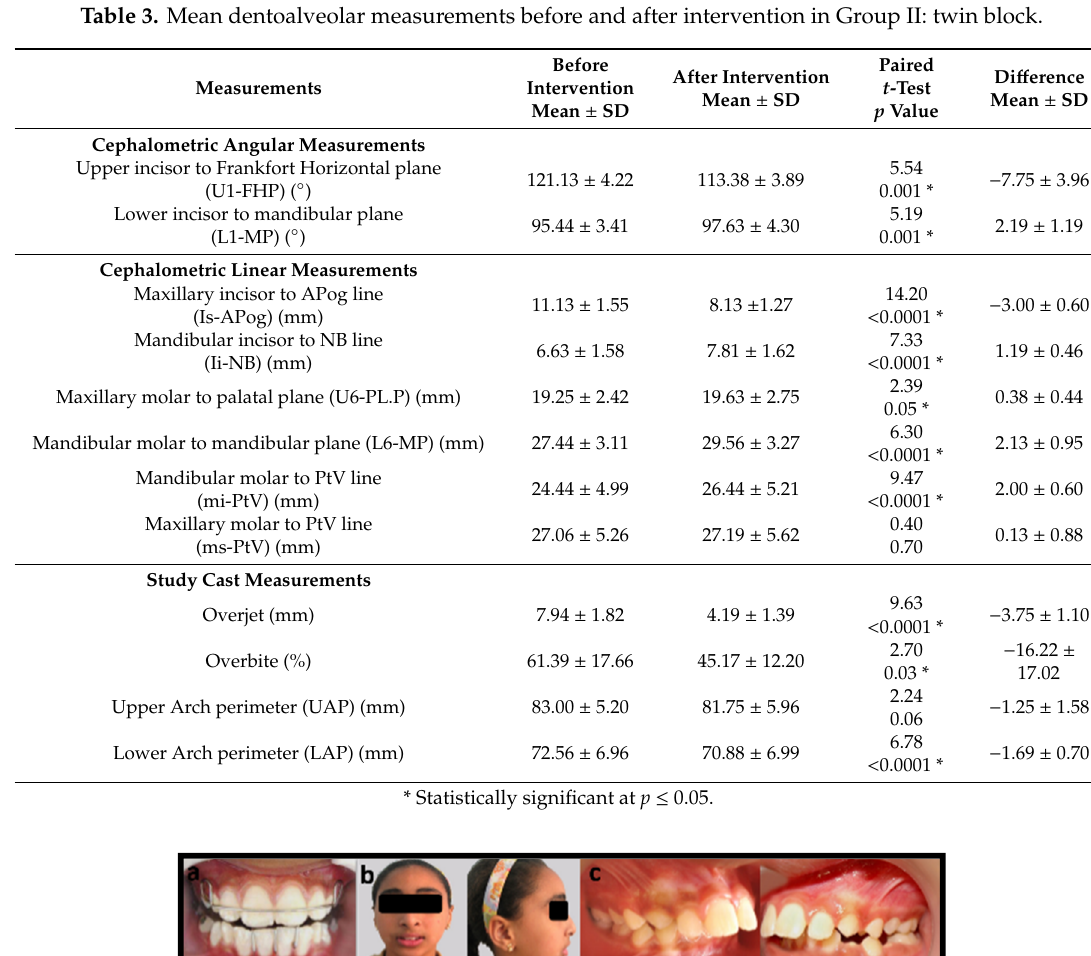
Table 4. Mean dentoalveolar angular and linear measurements change after intervention between Group I and Group II.